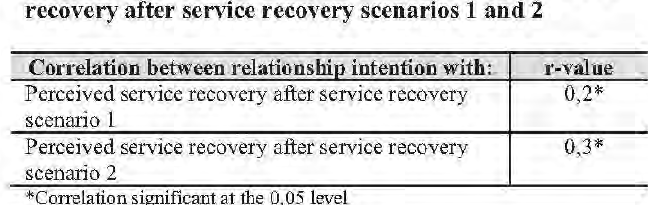
Table 5: Relationship intention and perceived